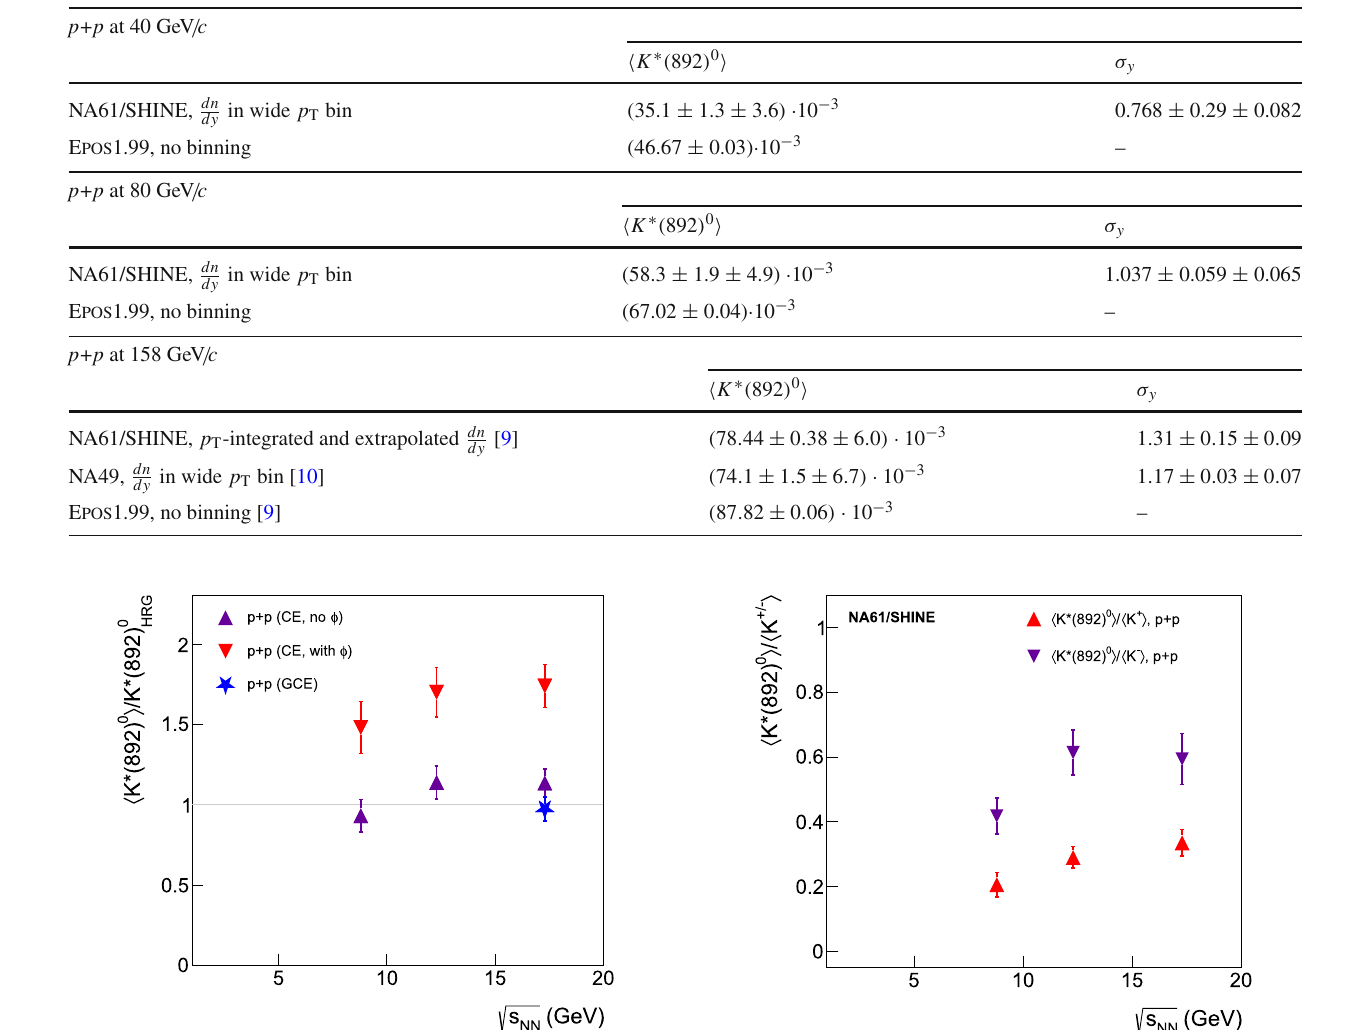
Table8 Themeanmultiplicitiesof K ∗ ( 892 ) 0 mesonsandthewidthsof and Ref. [9]), NA49 [10], and the Epos1.99 model. The first uncertainty the rapidity distributions σ y obtained from dn distributions (see the text dy for details). The results are presented for NA61/SHINE (this analysis